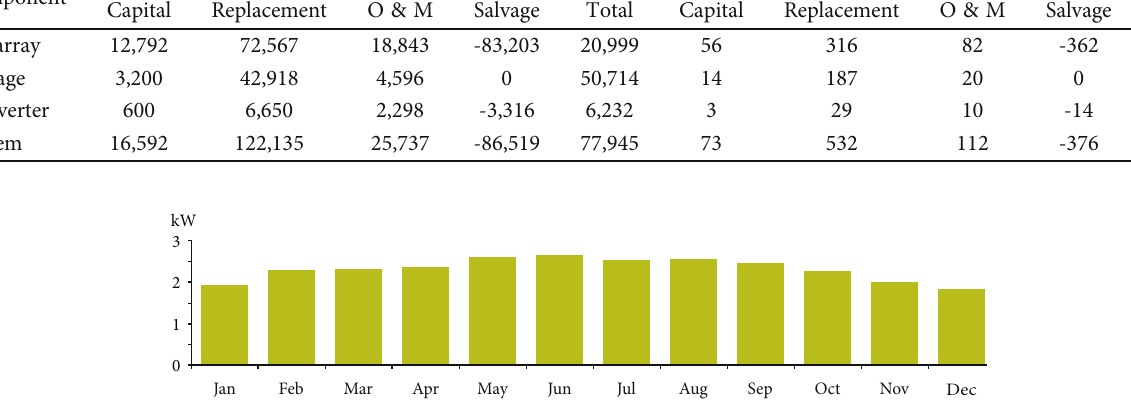
Figure 5: Monthly average electricity production via the under investigation